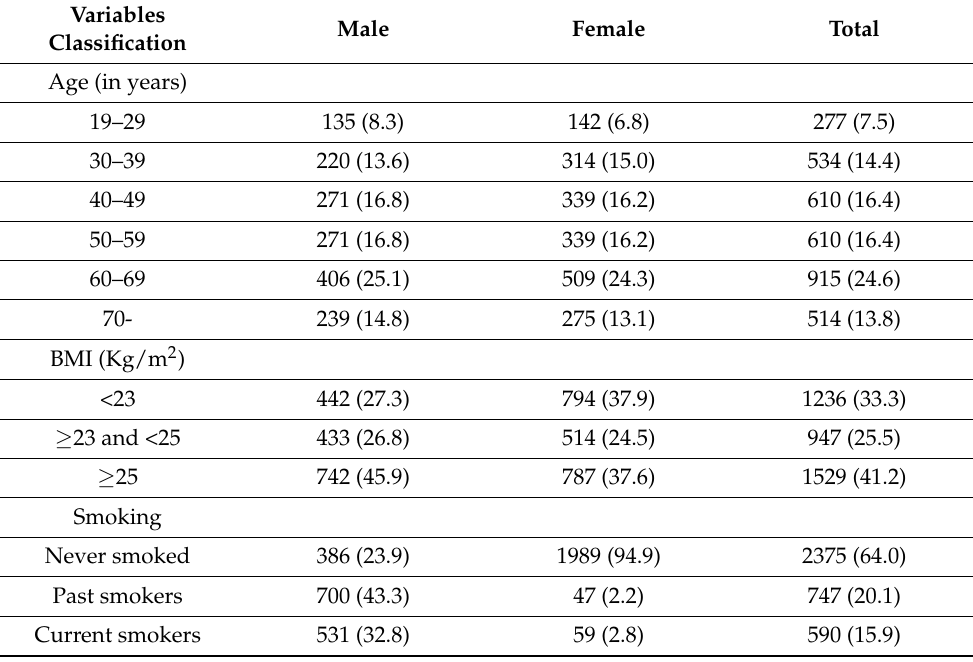
Table 1. General characteristics of study population by classification variables, KoNEHs